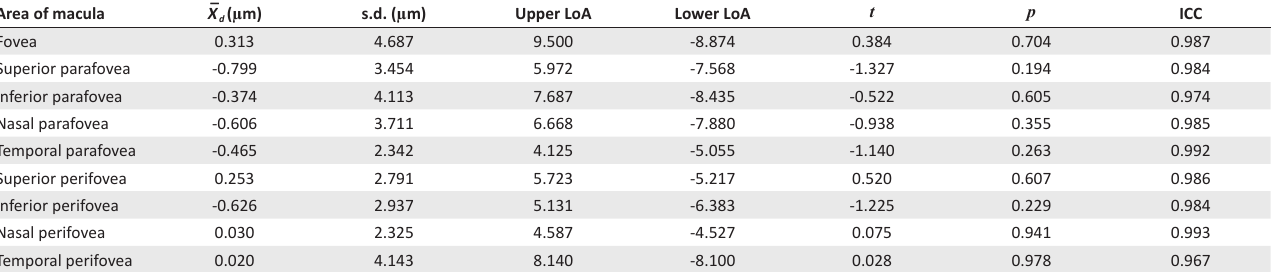
TABLE 3: The mean differences ( X‾ d ) and their standard deviations for iVue-100 macular thickness ( µ m) for observer one taken over two sessions (between 1 and 70 days apart), Bland-Altman upper and lower limits of agreement, and t - and p -values from paired t -tests and the intra-class correlation coefficients. Area of macula X‾ d ( µ m)